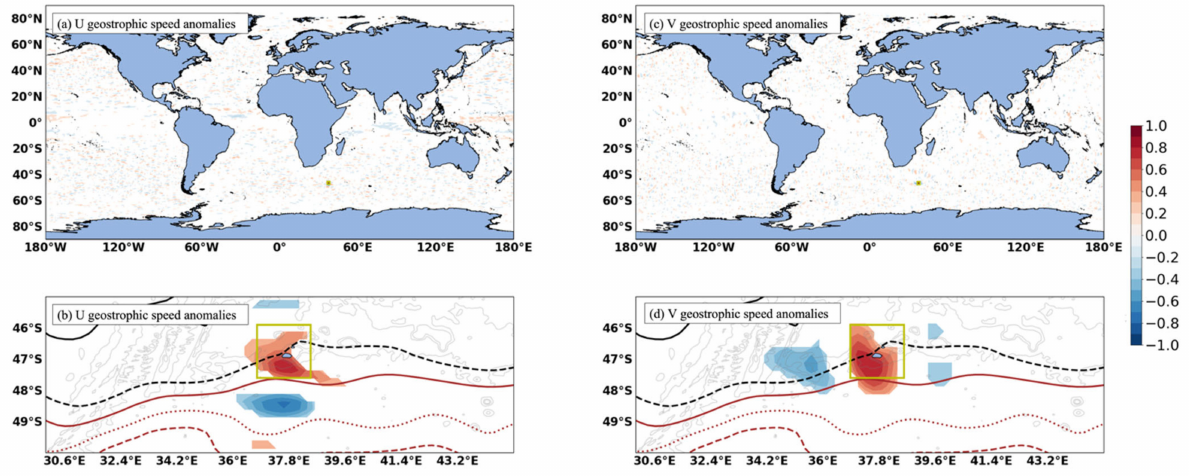
Figure 13. Maps of the significant correlation ( p -value < 0.05) between ( a ) zonal geostrophic current anomalies at the Prince Edward Islands (PEIs) and the zonal geostrophic current anomalies across the global ocean, ( c ) meridional geostrophic current anomalies at the PEIs and across the global ocean. The zoomed maps show the regions of strong correlation ( − 0.3 < R > 0.3) region for ( b ) zonal geostrophic current anomalies, and ( d ) meridional geostrophic current anomalies around the PEIs. The yellow box indicates the 2 ◦ × 2 ◦ area around the PEIs within which data were averaged for time series